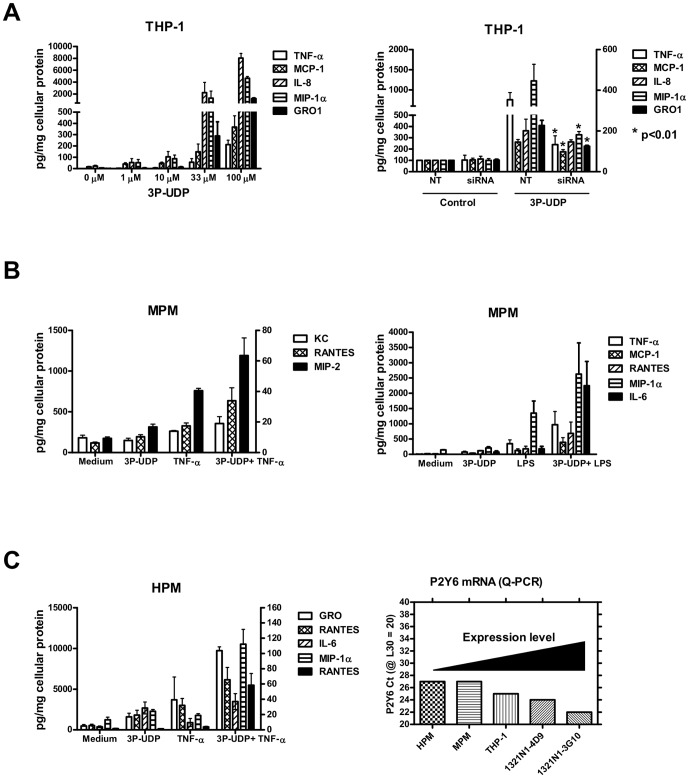
P2Y6 receptor agonism modulates inflammatory cytokine release from macrophages.Activation of P2Y6 with 3P-UDP potentiates secretion of pro-inflammatory cytokines in macrophages. A) Differentiated THP-1 macrophages were incubated for 16 hr with increasing concentrations of 3P-UDP and cytokines in cell medium analyzed using multiplex ELISA. Cytokines which were affected by 3P-UDP treatment are shown (left graph). On the right, THP-1 monocytes were differentiated in presence of control non-targeting (NT) or P2Y6 siRNA (siRNA) and treated with 33 µM 3P-UDP for 16 hr to determine cytokine levels in medium. The level of P2Y6 mRNA knockdown was 78%. The data are presented as mean +/−SD of replicate wells from a representative experiment. Significance P2Y6 siRNA vs non-targeting siRNA: *p<0.01. B) Adhered mouse peritoneal macrophages were incubated in serum-free medium for 16 hr with combinations of 100 µM 3P-UDP either alone or in the presence of additional inflammatory stimulus (0.1 ng/mL TNF-α or 10 ng/mL LPS) and analyzed for cytokines levels in cultured medium using ELISA. C) Human primary monocyte-derived macrophages were incubated with 100 µM 3P-UDP either alone or in the presence of 10 pg/mL TNF-α and analyzed for cytokine levels as described in Materials and Methods. Relative expression of P2Y6 mRNA in each cell line was compared using quantitative PCR Threshold Cycle (Ct) values. P2Y6 Ct values were normalized to RPL30 (set at Ct  =  20) and plotted to illustrate relative expression compared to abundant RPL30 housekeeping gene (Ct  =  20) or genes expressed at the very low levels (Ct> 35).